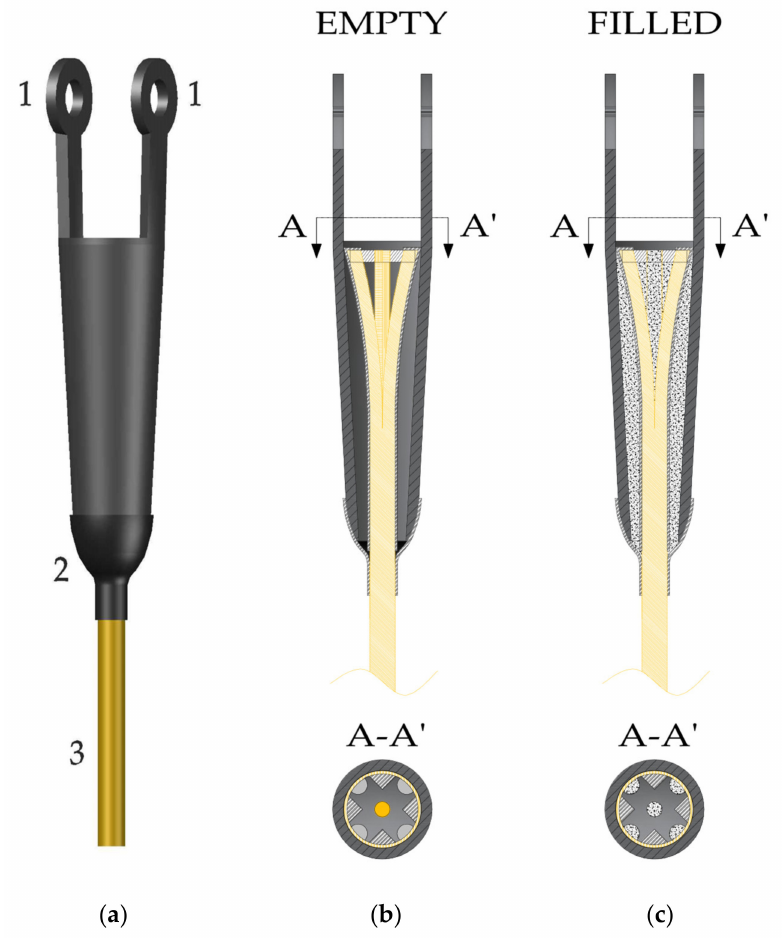
Figure 7. Spike anchorage proposed by Davis [20]: ( a ) 3D representation; ( b ) Four portions of a GFRP cable are first separated by a spacer-spreader; ( c ) Empty spaces are then filled with resin binder. In detail: 1—attaching aligned openings; 2—elastomeric seal; 3—GFRP cable. A similar solution (Figure 8) was proposed [21] by Arnautov et al. (2014). The tested